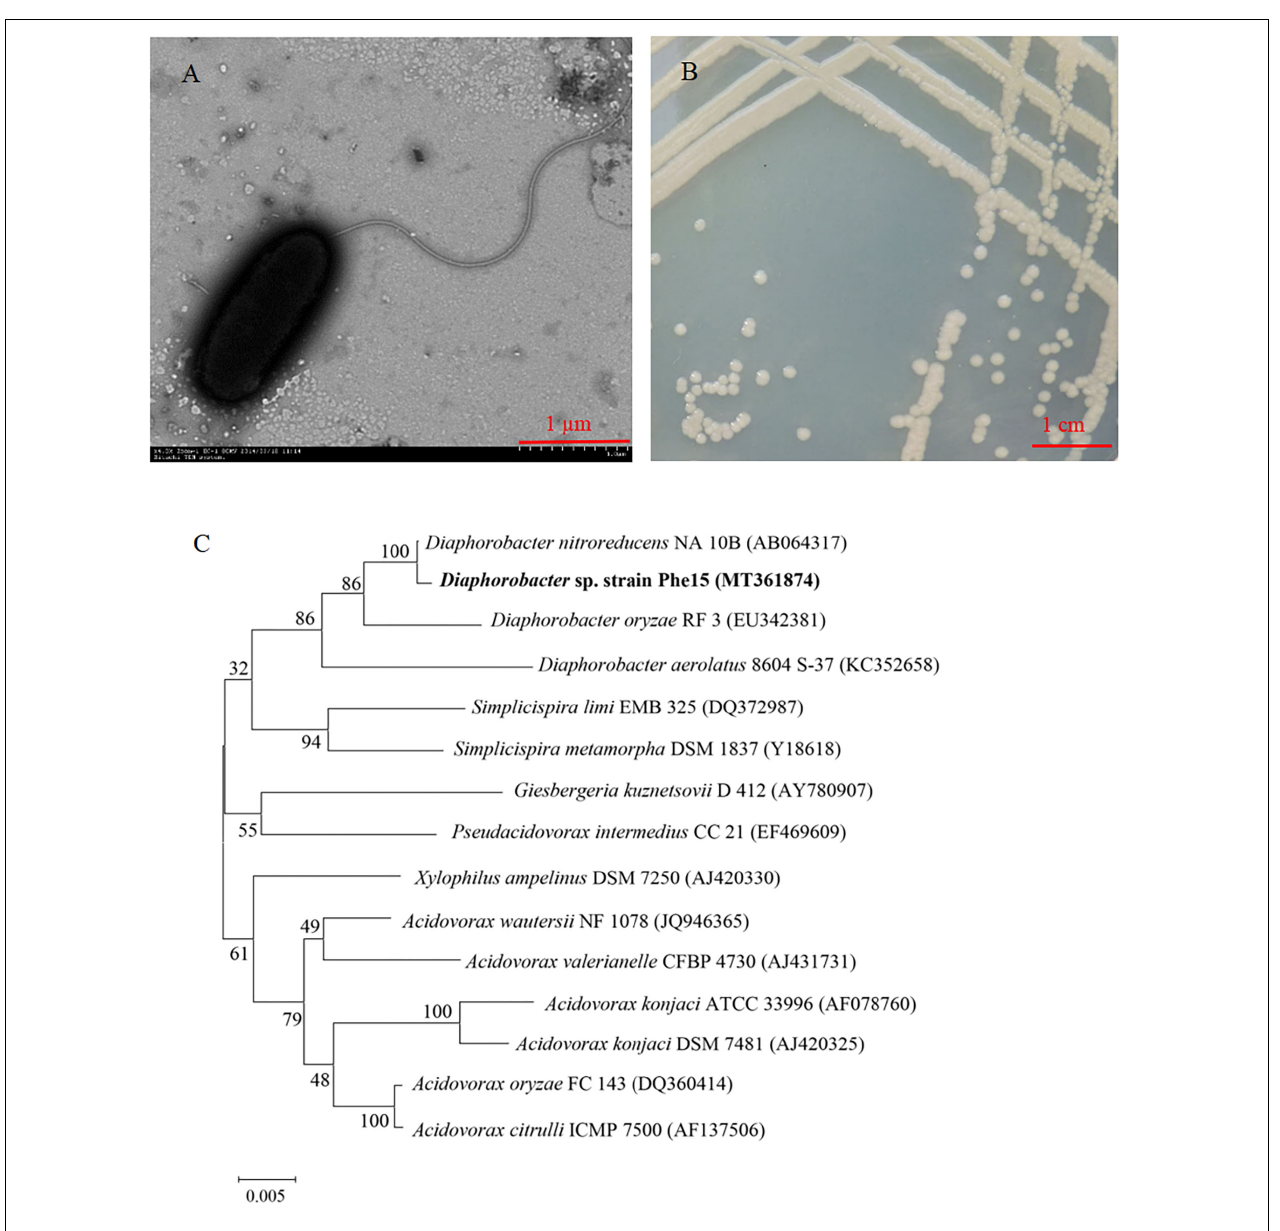
FIGURE 1 | The identification of strain Phe15. (A) Transmission electron micrograph of strain Phe15 ( × 4.0 k Zoom − 1 HC − 1 80 kV); (B) Colonial morphology of strain Phe15 on LB agar plate; (C) Phylogenetic analysis of strain Phe15 and related species using the neighbor joining method. Bootstrap values (%) are indicated at the nodes in a bootstrap analysis of 1000 replicates. The scale bar indicates 0.005 changes per nucleotide. The Gen Bank accession number for each bacterium used in the analysis is shown in parentheses after the species